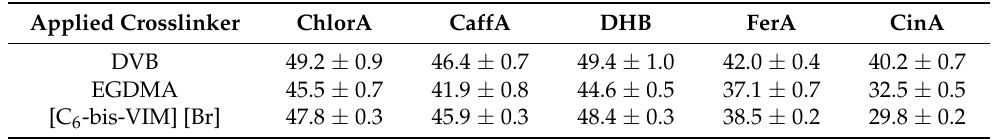
Table 1. Calculated loading capacities obtained from DSPE experiments with three differently crosslinked vinylimidazole